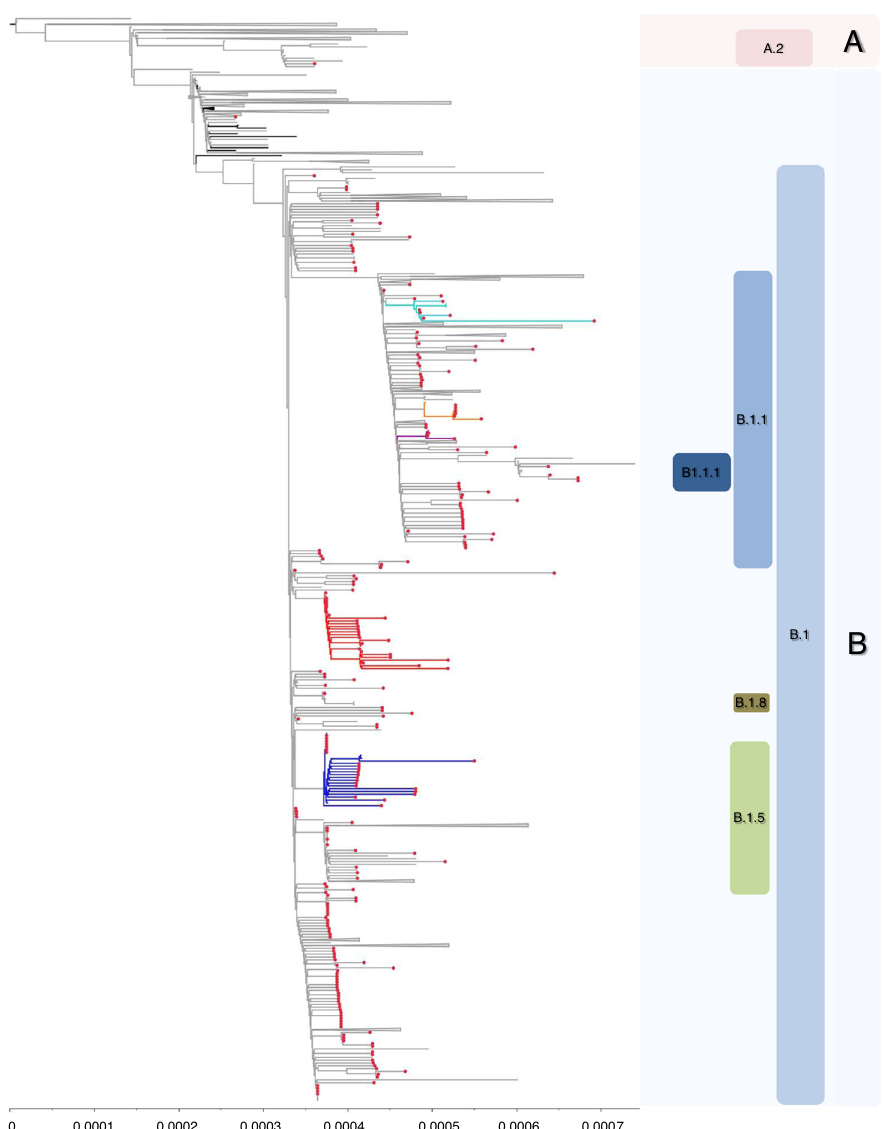
Fig. 2 Estimated maximum likelihood phylogeny of SARS-CoV-2 genomes from Lombardy (gray taxa with red dots) and genomes from China (black taxa without dots) and other countries (gray taxa without dots), according to lineages. Local clusters supported by a posterior probability ≥ 0.98 in the maximum clade credibility tree were highlighted in red ( A ), in blue ( B ), in cyan ( C ), and in orange ( D ). Gisaid sequences come from Italy ( n = 15), East Europe ( n = 15), North Europe ( n = 10), South America ( n = 13), Africa ( n = 8), Japan ( n = 10), Oceania ( n = 25), West Asia ( n = 17), South Asia ( n = 14), Central Europe ( n = 30), East Asia ( n = 46), The Netherlands ( n = 41), South East Asia ( n = 19), North America ( n = 52), British Countries ( n = 47), China ( n = 55). The phylogeny was estimated with Iqtree with 1000 replicates fast